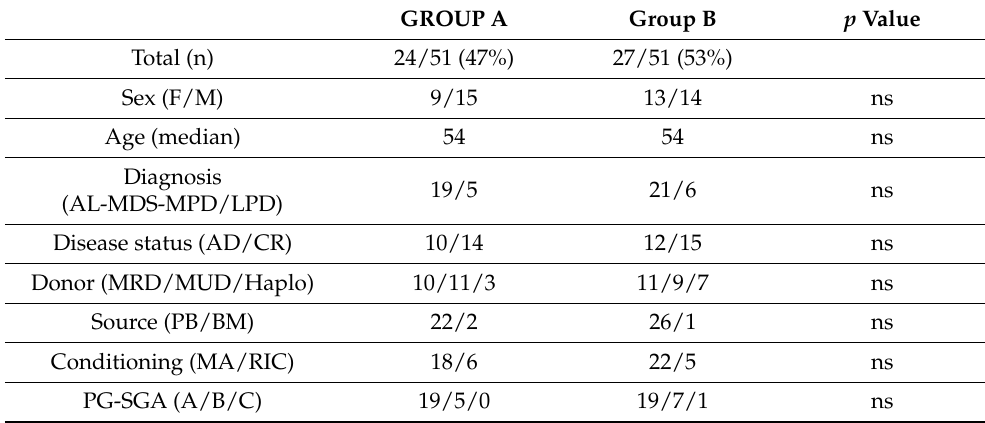
Table 2. Basal characteristics according to the Treatment Ratio